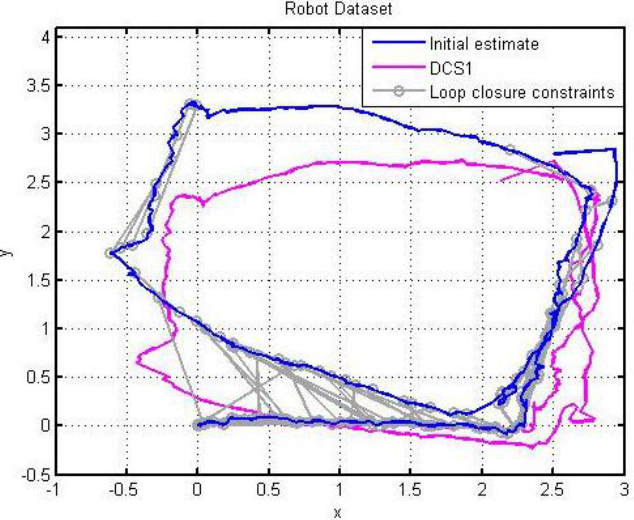
Figure 16. The optimization of Robot trajectory by the improved RGB-D SLAM based on Dr Robot